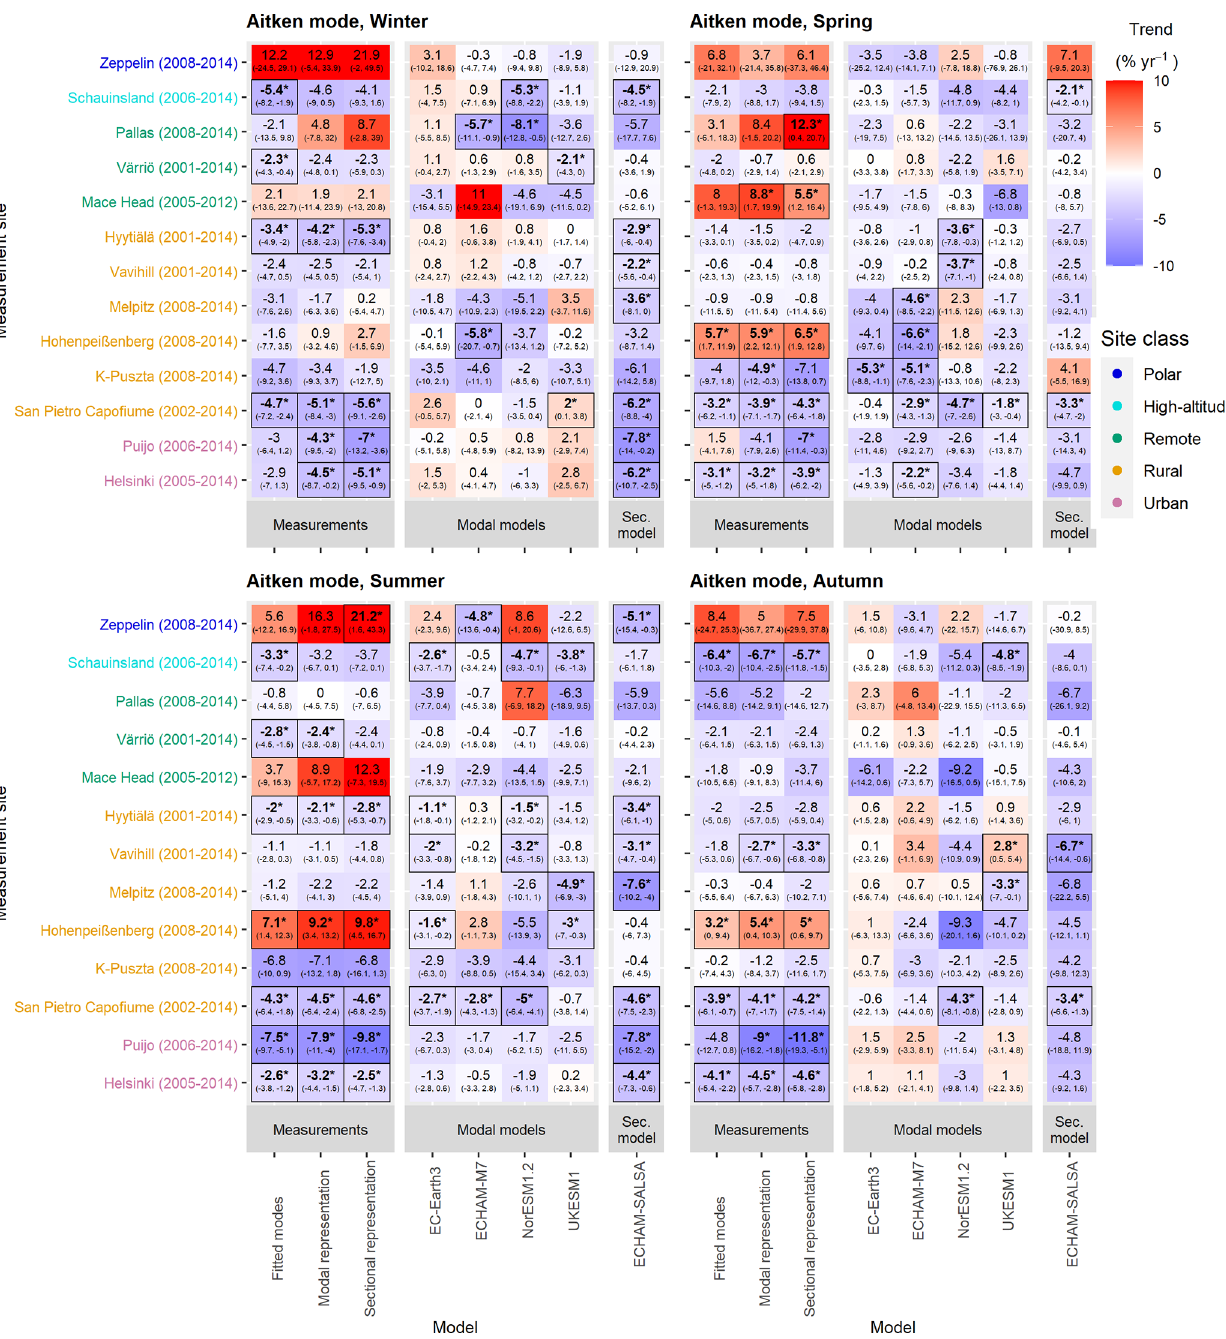
Figure 9. Seasonal trend estimates for Aitken mode number concentration for four seasons: winter (January, February, December), spring (March, April, May), summer (June, July, August), and autumn (September, October, November). Sites are ordered by site class and within site class most northerly to most southerly. Bold numbers, asterisks, and line borders around the estimate indicate that the trend is statistically significant (95% confidence level). Trends have been calculated using the Sen–Theil estimator and complemented with bootstrap confidence intervals (see Sect.